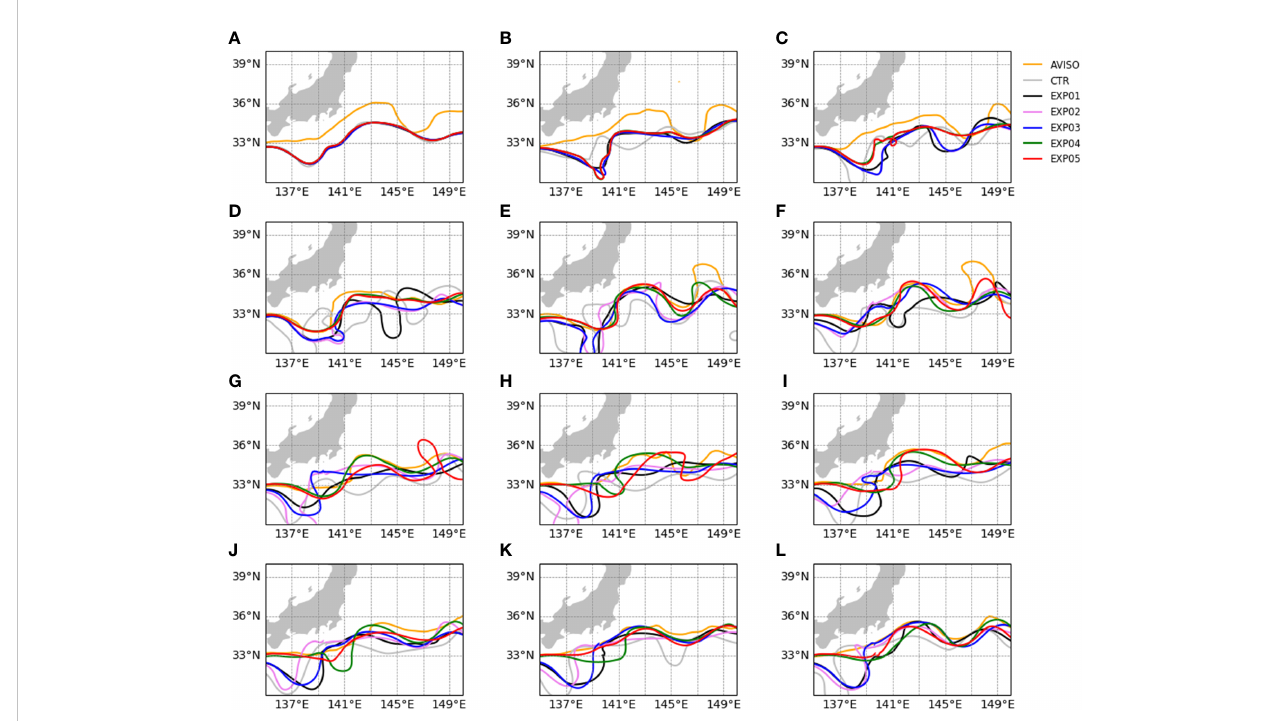
FIGURE 8 Monthly mean Kuroshio axis is denoted by the 0.6m SSH. A – L represent results in January-December, respectively. Orange line denotes Kuroshio axis from the AVISO gridded data. Gray, black, violet, blue, green and red lines denote Kuroshio axis of CTR and EXP01-05, respectively.